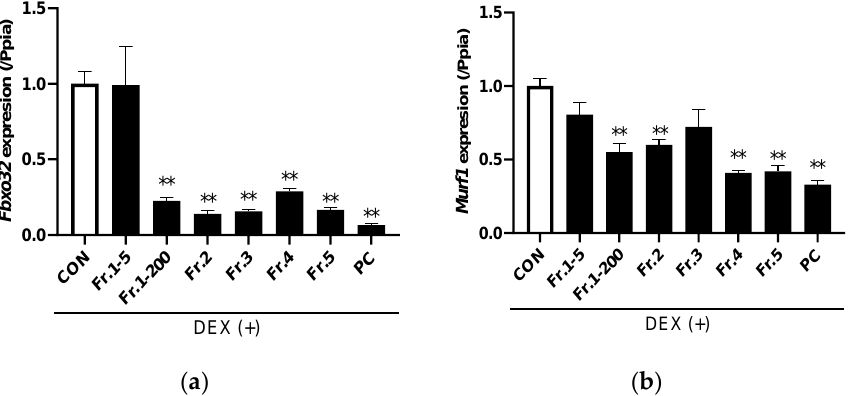
Figure 5. Effects of five turmeric extract (TE) fractions on the gene expression of muscle-specific ubiquitin ligase in dexamethasone (DEX) – treated C2C12 myotubes. ( a ) and ( b ) Gene expression of Fbxo32 and Murf1, respectively. The positive control group was treated with 10 nM of IGF-1 for 12 h. The results are shown as the mean ± standard error ( n = 4), and statistical analysis was performed by Tukey-Kramer test. ** p < 0.01 vs. Control, N.S.: not significant.